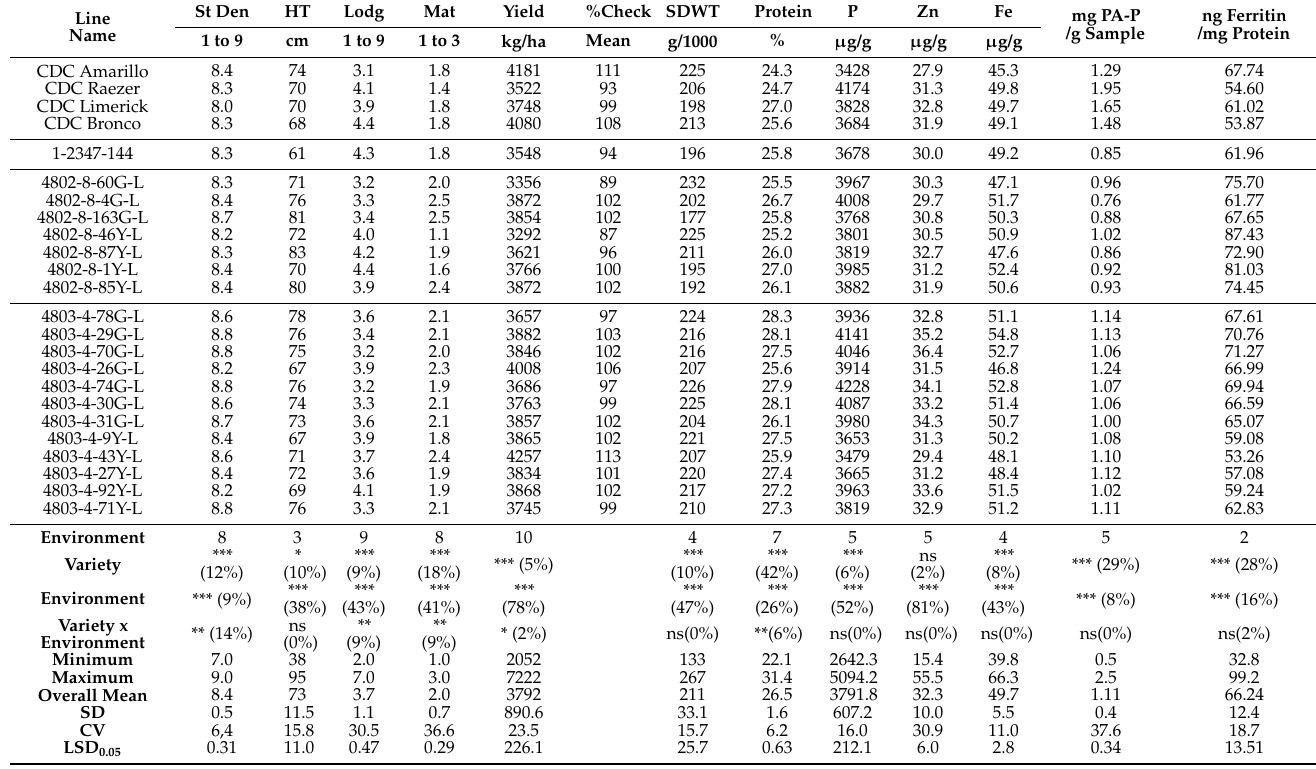
Table 1. Analysis of variance and mean values for agronomic and seed quality traits of 24 pea varieties evaluated over 2